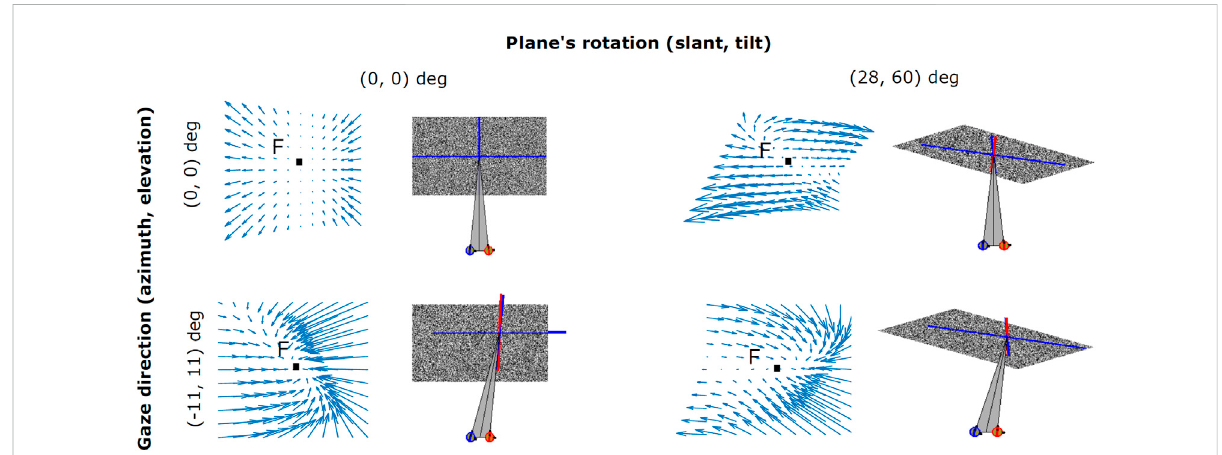
FIGURE 4 Examples of binocular disparity patterns related to angled planes observed under different viewpoints. Both the change in the cyclopean gaze direction ( α , ϵ ) (0 ° , 0 ° ) and (11 ° , 11 ° ), and the plane ’ s rotation in depth ( σ , τ ) (0 ° , 0 ° ) and (28 ° , 60 ° ) result in distortions (i.e., rotational components) in the disparity vector fi